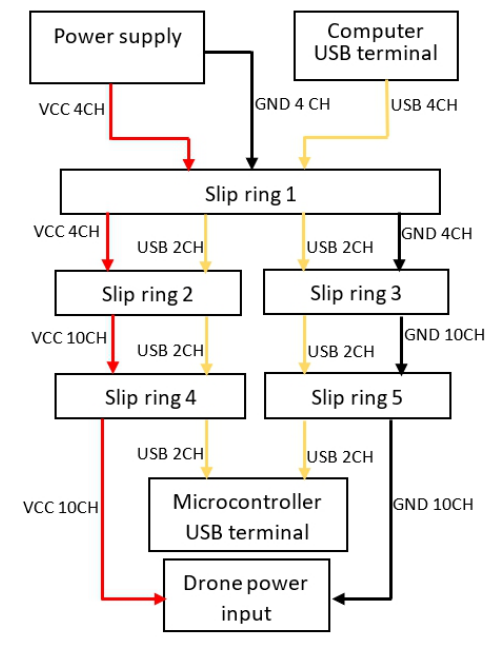
Figure 8. Test platform electrical connection diagram. Red and black arrows indicate VCC and GND power transmission poles. USB com- munication is represented by yellow arrows. The number of channels used between each connection is shown next to each